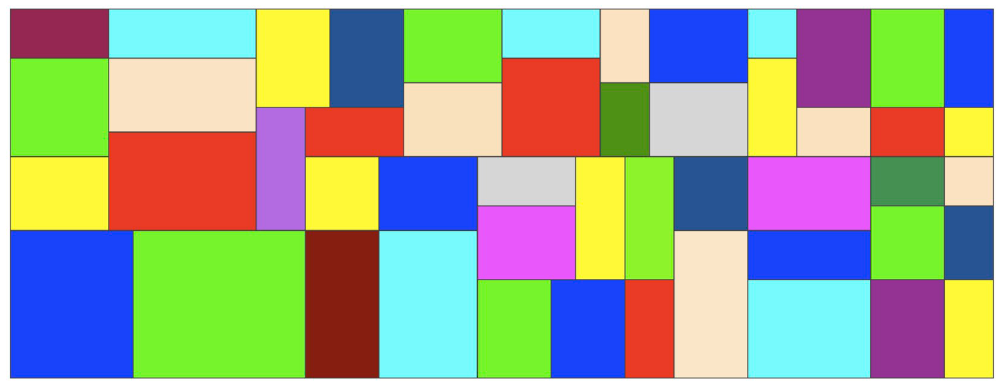
Fig 1. Example for 2SP. The optimal configuration for an instance proposed by [6] with 50 items, a strip of width W = 40, and an optimal height H = 15.